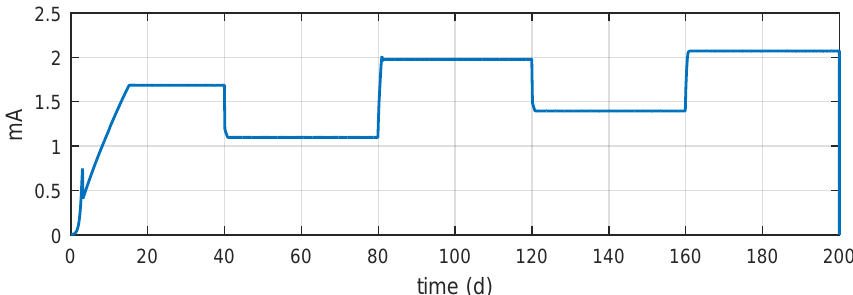
Figure 20. Current intensity in the